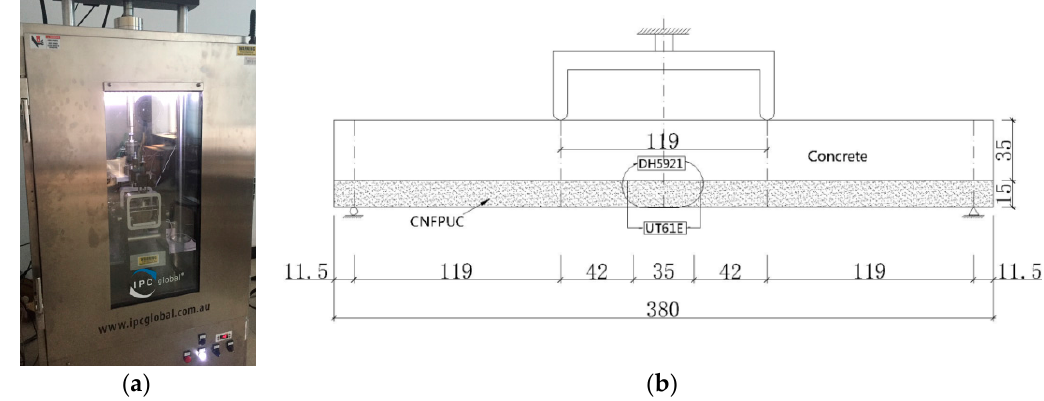
Figure 4. Four-point bending fatigue test. ( a ) Fatigue test device; ( b ) two electrode position diagram (mm).